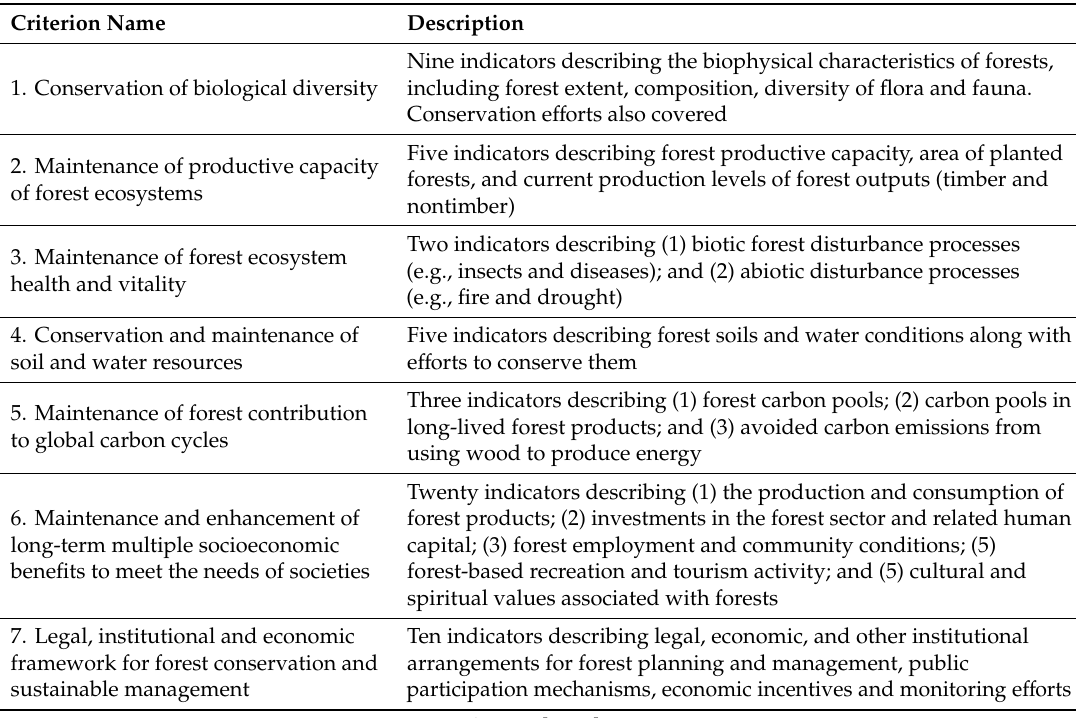
Table 1. Montreal Process Criteria and Indicators criterion level summary.